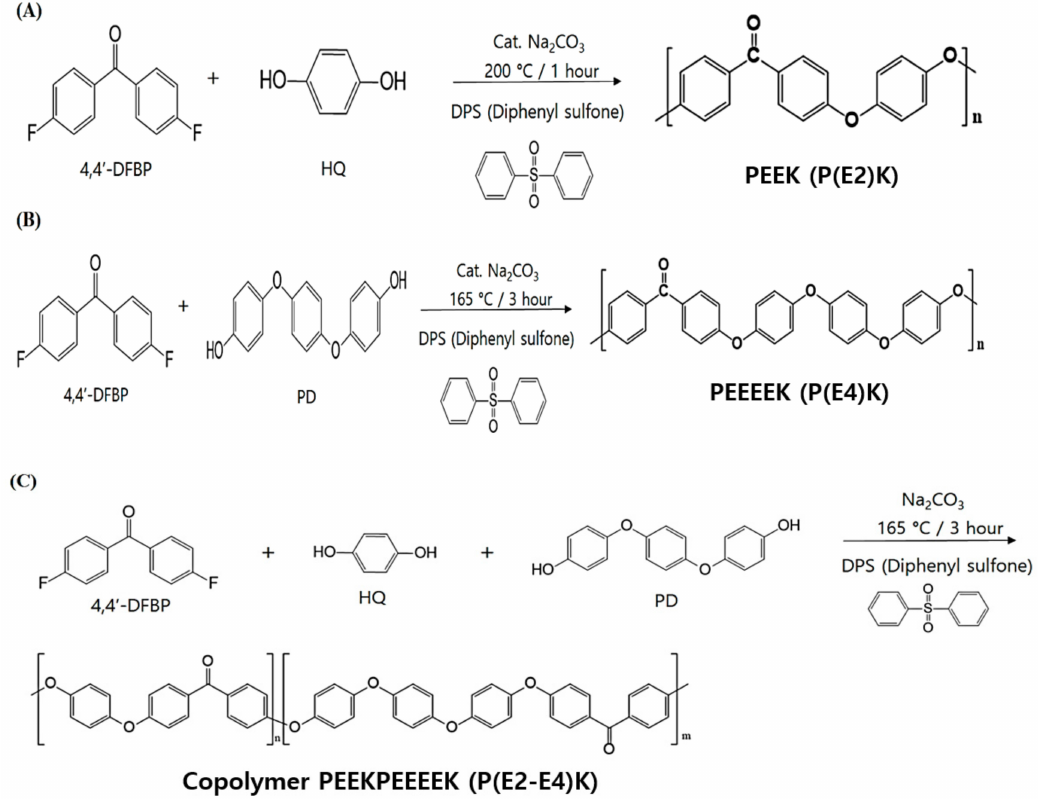
Figure 1. Chemical synthesis schemes of the PEEK polymers for controlling the number of ether groups in the repeating unit. ( A ) PEEK polymerization for P(E2)K, ( B ) PEEEEK polymerization for P(E4)K, and ( C ) the copolymerization of P(E2)K and P(E4)K to P(E2–E4)K. Table 1. Formulation ratios of the PEEK composites. Sample